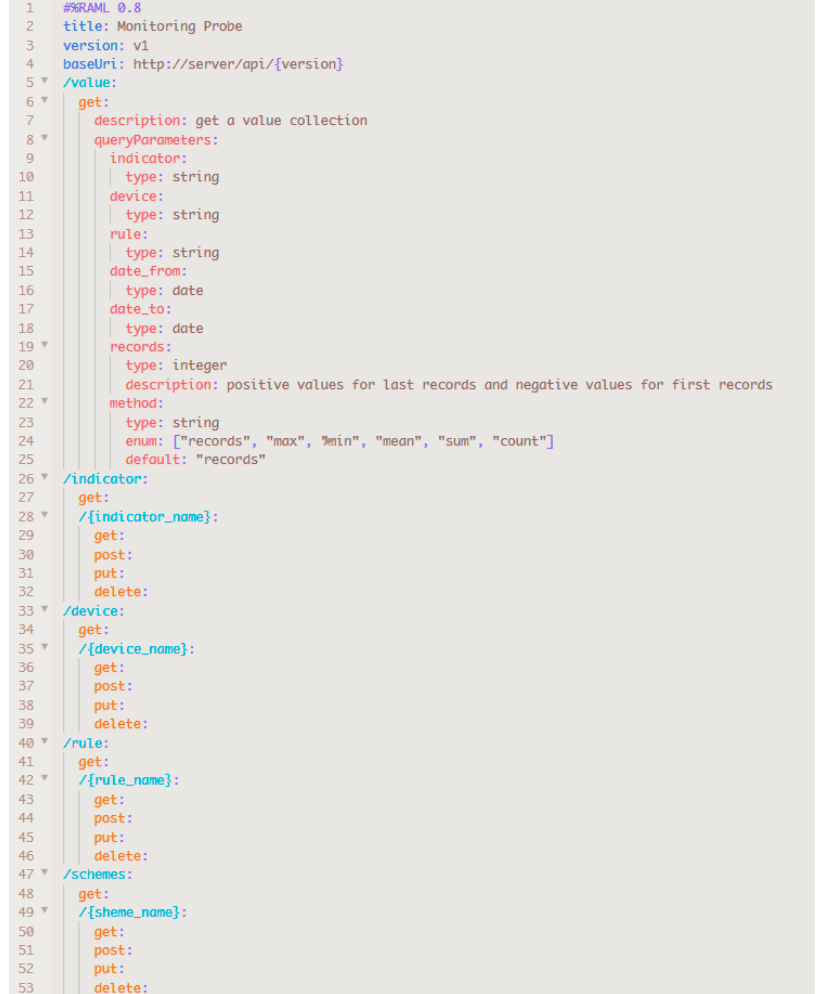
Figure 4. Fragment of the monitoring service contract definition in representational state transfer (RESTful) API modeling language (RAML).